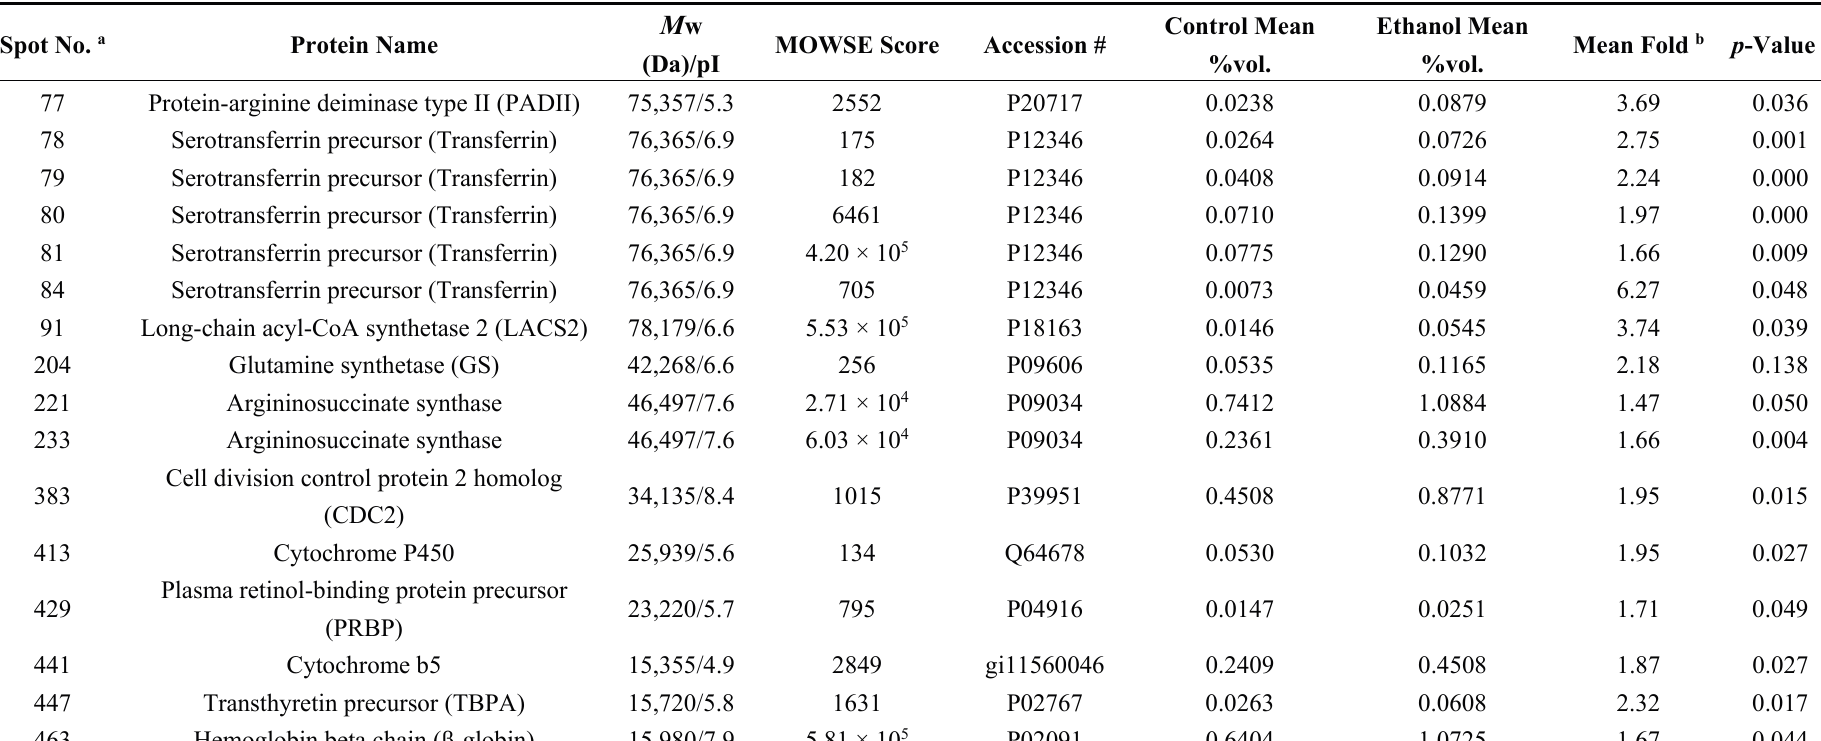
Table 4. Up-regulated proteins in liver cytoplasmic fractions following chronic ethanol consumption: identification of proteins from 2D IEF/SDS-PAGE